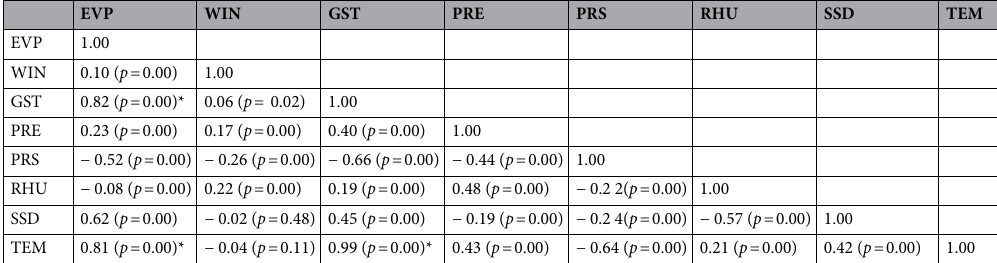
Table 5. Pearson’s correlation coefficient(‘r’)matrix of meteorological variables in Anhui, China, 2010–2020. *The variables with a threshold of Pearson’s correlation |r|> 0.7.